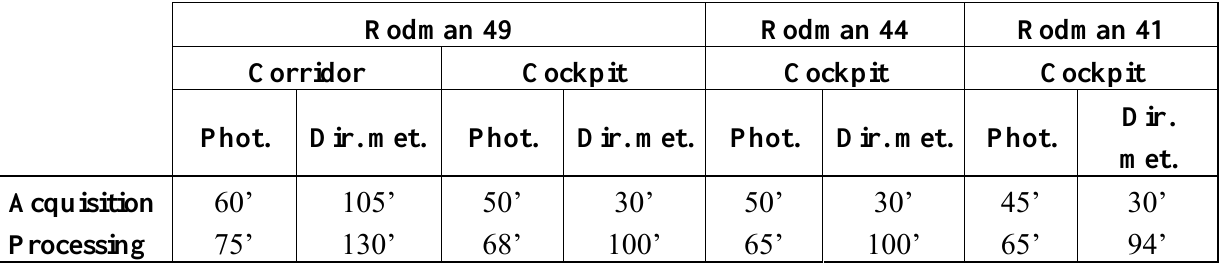
Table 2. Comparison of time consumption (in minutes) for the measurement of pieces of boat decks for both of the methods